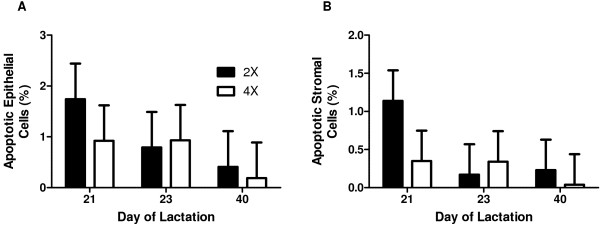
Mammary cell apoptosis. Percentage of apoptotic A. epithelial or B. stromal cells in mammary tissue of cows (n = 6) assigned to unilateral frequent milking (UFM; twice daily milking (2×) of the left udder half, four times daily milking (4×) of the right udder half) for days 1 to 21 of lactation. Mammary biopsies from both udder halves were obtained on d 21, 23, and 40 of lactation. Each bar represents Least Squares mean ± pooled standard error. Mammary cell apoptosis was not affected by 4× milking or by day of lactation (P ≥ 0.30).